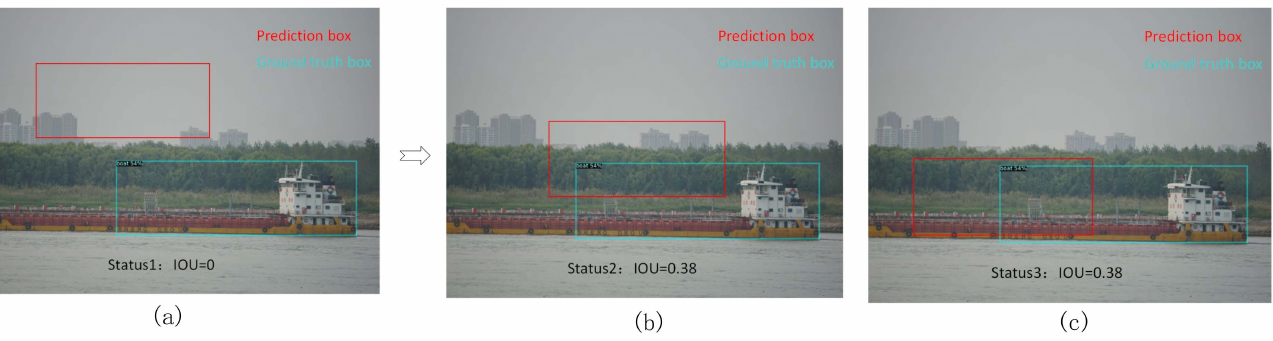
Figure 9. Schematic diagram of different overlapping shapes of IOU. ( a ) status1: IOU = 0. ( b ) sta- tus2: IOU = 0.38. ( c ) status3: IOU =